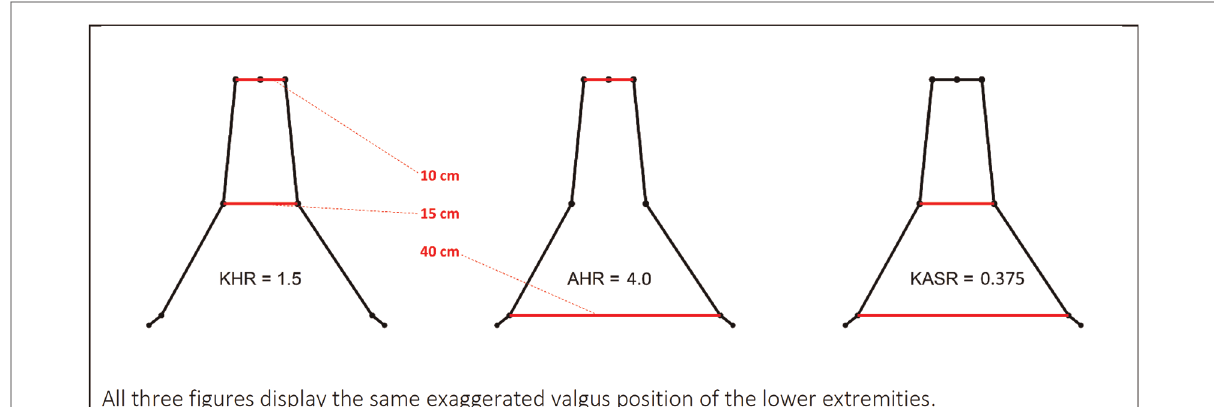
FIGURE 1 Frontal plane kinematic variables. All three fi gures display the same exaggerated valgus position of the lower extremities. AHR, ankle-to-hip separation ratio; KHR, knee-to-hip separation ratio; KASR, knee-to-ankle separation